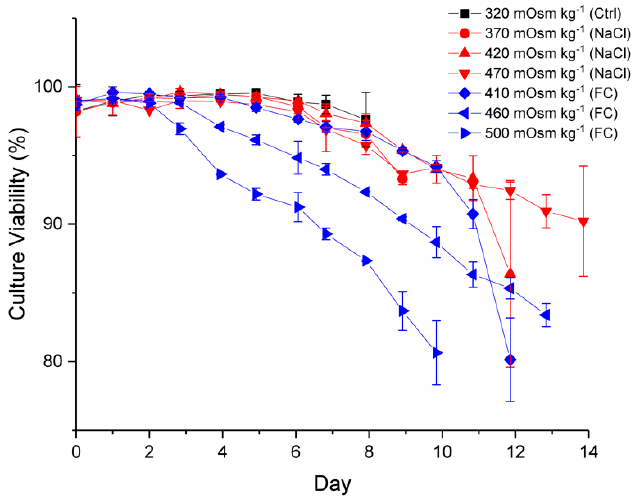
Figure A1. Culture viability profile across different osmolality values. The cultures were harvested on the day after the final measurement reported herein, when the viability in one of the biological duplicates dropped below 80%.